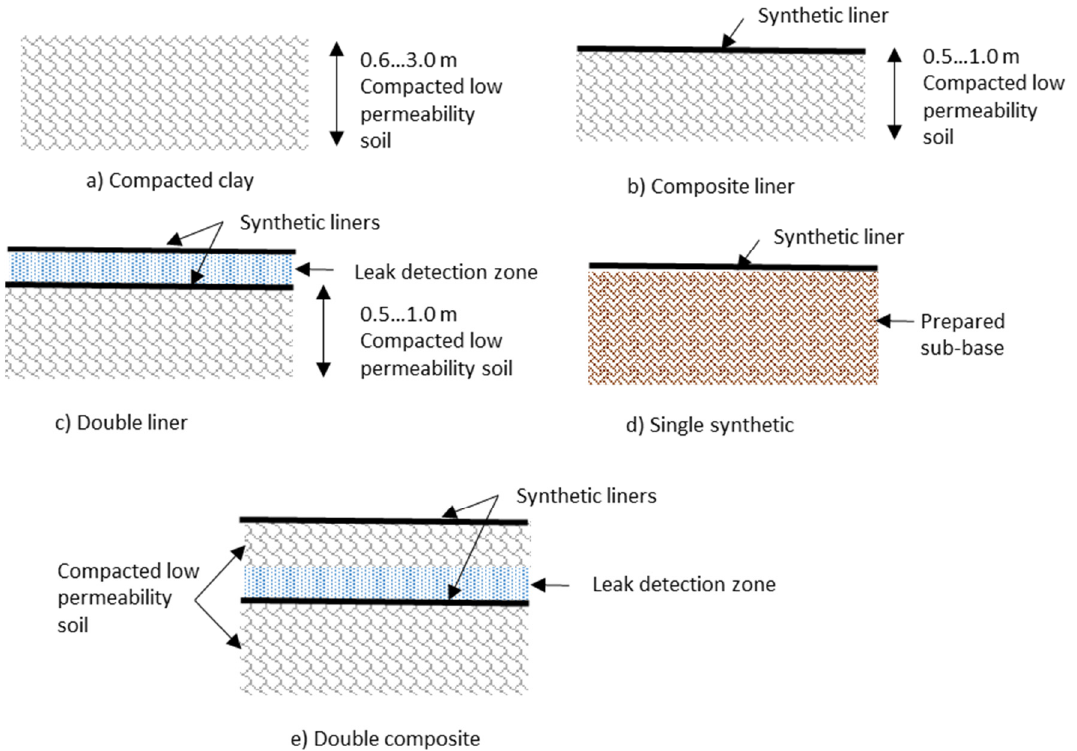
Figure 6. Example of different liner systems ( a ) compacted clay, ( b ) composite liner, ( c ) double liner, ( d ) single synthetic, and ( e ) double composite specified for use in the United States if low hydraulic conductivity is required, modified from [58,59].